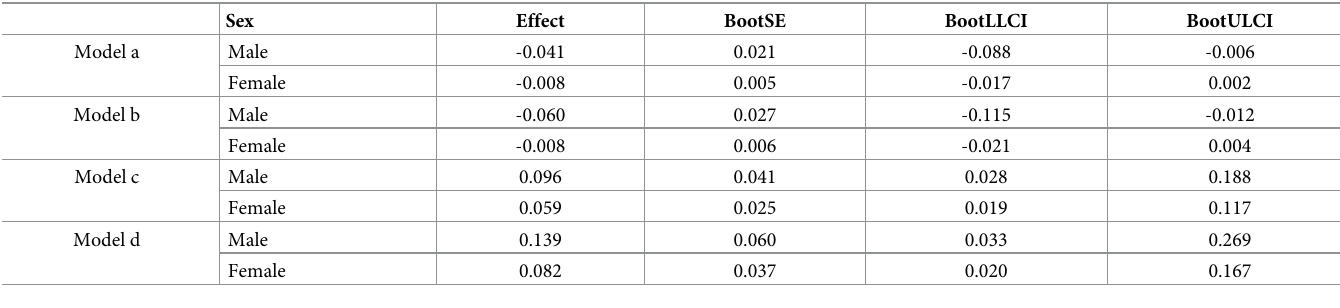
Table 6. Results of the indirect effect analysis.